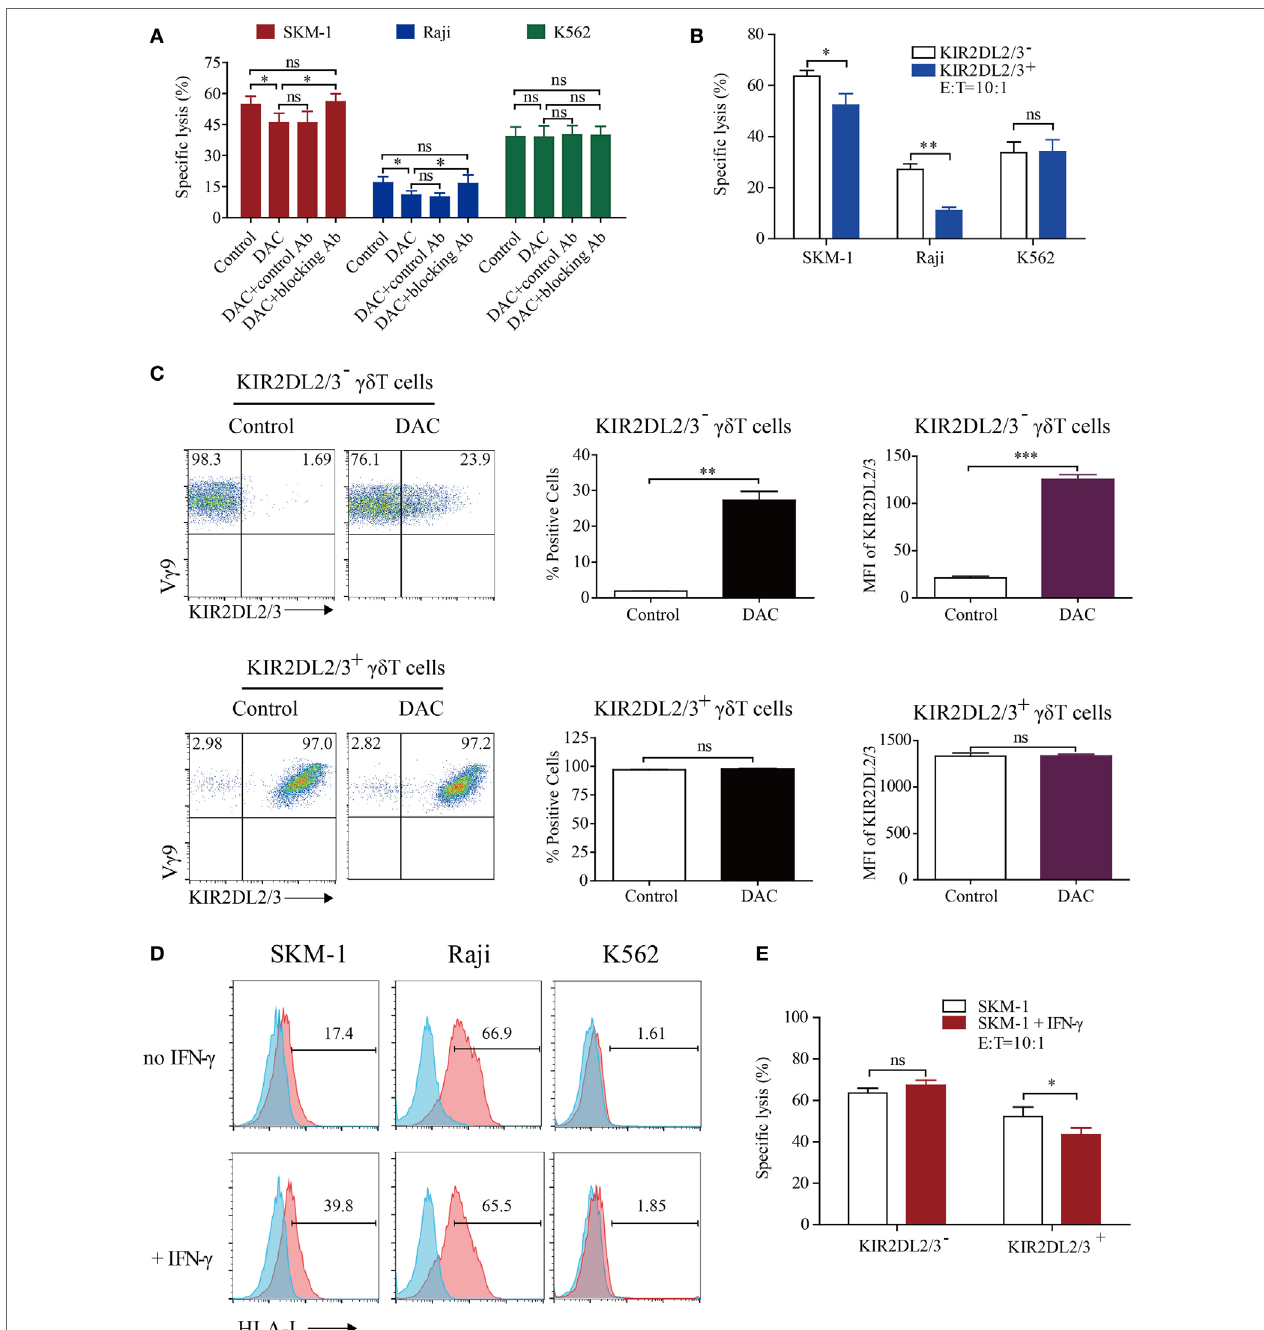
FigUre 3 | Decitabine induced polarization of KIR2DL2/3-negative gamma delta ( γδ ) T cells to KIR2DL2/3-positive cells, which are less cytotoxic to tumor cells expressing HLA-I molecules than KIR2DL2/3-negative γδ T cells. (a) The decrease in γδ T cell killing was inhibited by the KIR2DL2/3-blocking antibody (Ab). The 0.5 µM DAC-treated γδ T effector cells were first treated with or without Abs to KIR2DL2/3 for 30 min and then incubated with target cells at 37°C for 4 h to test the cytotoxicity (* p < 0.05; ns, not significant; n = 3). (b) The cytotoxicity of KIR2DL2/3-positive and -negative γδ T cells to tumor cells. KIR2DL2/3-positive and -negative γδ T cells were incubated with Raji, SKM-1, and K562 cells at 37°C for 4 h to test the cytotoxicity ( n = 3; * p < 0.05; ** p < 0.01; ns, not significant). (c) Effect of DAC on KIR2DL2/3 expression on KIR2DL2/3-positive and -negative γδ T cells. KIR2DL2/3-positive and -negative γδ T cells were sorted from cultured γδ T cells and treated with 0.5 µM DAC for 48 h. FACS dot plots showing the changes of KIR2DL2/3 on KIR2DL2/3-positive and -negative γδ T cells after treatment with DAC. Graph showing the percentage and mean fluorescence intensity (MFI) of KIR2DL2/3 on KIR2DL2/3-positive and -negative γδ T cells after treatment with DAC (** p < 0.01; *** p < 0.001; ns, not significant; n = 3). (D) HLA-I molecule expression on tumor cells and interferon (IFN)- γ -treated tumor cells. Tumor cells were first treated with 200 IU/mL IFN- γ for 48 h, and then harvested and stained with mouse anti-human HLA-I molecular Ab. (e) The cytotoxicity of KIR2DL2/3-positive and -negative γδ T cells to SKM-1 cells and IFN- γ -treated SKM-1 cells (* p < 0.05; ns, not significant; n = 3).